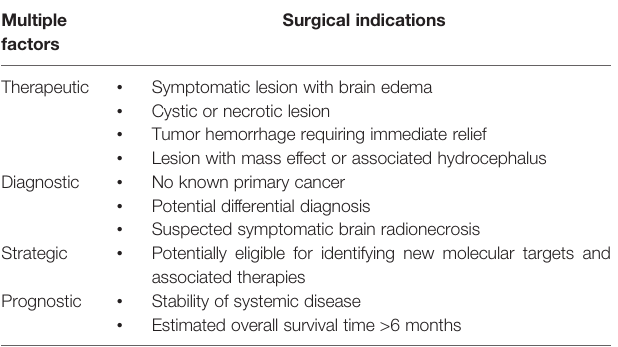
TABLE 2 | Indications for surgery of BM in the perirolandic